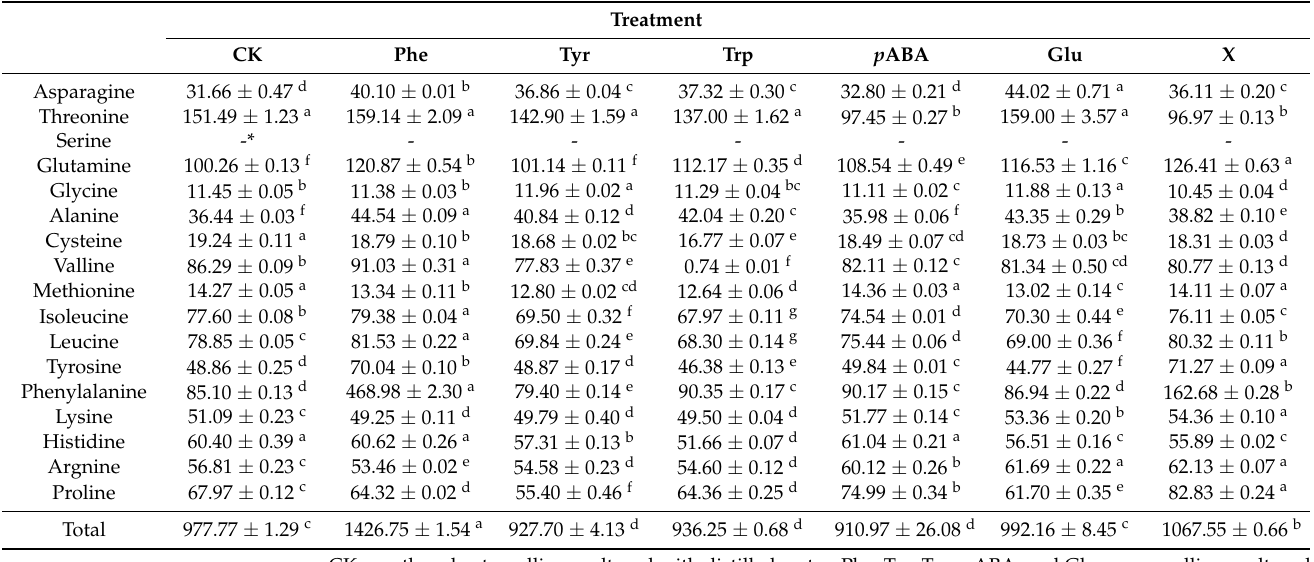
Table 3. Concentrations (mg/100 g DW) of free amino acids in wheat seedlings cultured with amino acids ( n =